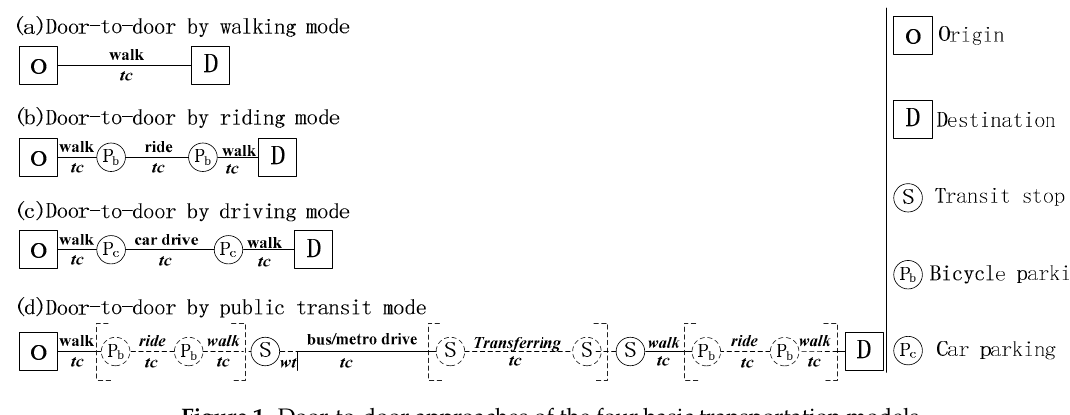
Figure 1. Door-to-door approaches of the four basic transportation models.